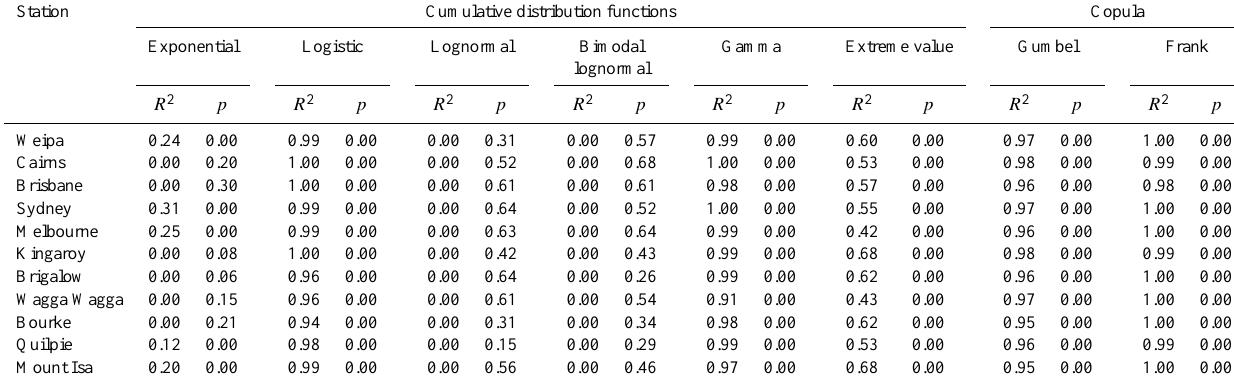
Table F1. R 2 and p values for fitted cumulative distribution functions and Copula parameters for the studied sites.